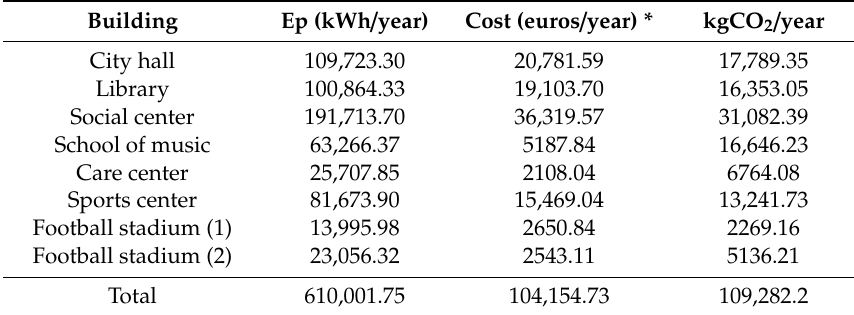
Table 1. Pilot municipality calculations: ideal